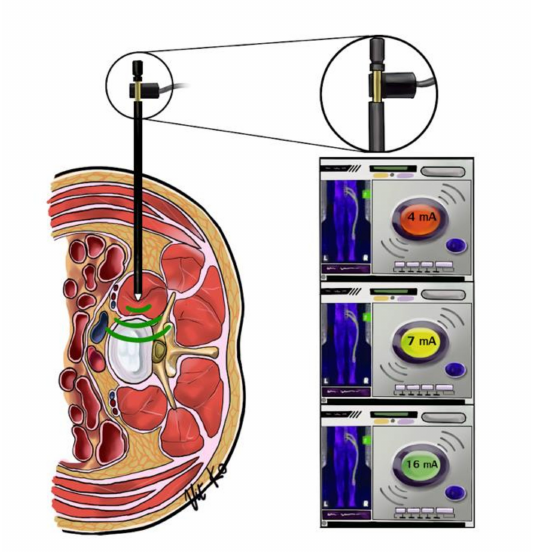
Figure 2. Depicting a neuromonitoring device attached to a serial dilator while gaining a direct access through the psoas major muscle. Note that there are three level of alertness: safe from lumbosacral plexus (green), caution (yellow), and close to the nerve (red).